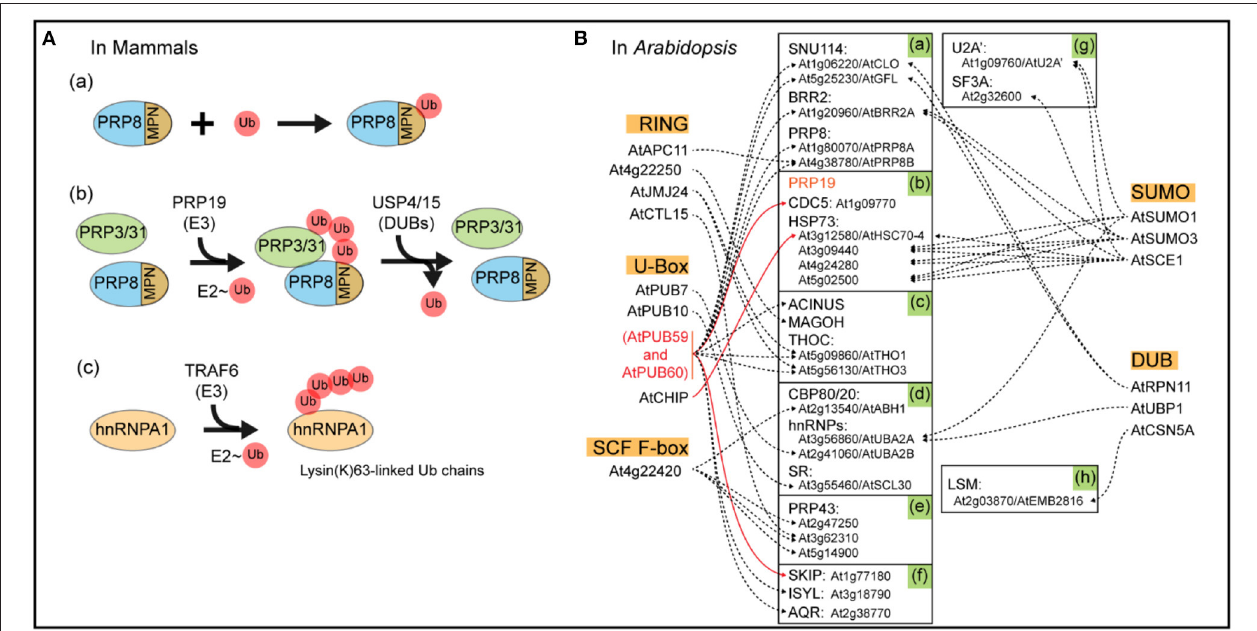
FIGURE 2 | Schematic diagram of ubiquitination in mammals and Arabidopsis. (A) Ubiquitination and deubiquitination of mammalian spliceosomal components. MPN, the MPN domain, a variant of the Jab1/MPN domain found in a class of deubiquitinating enzymes, located near the C terminus of PRP8p; Ub, Ubiquitin. (B) The ubiquitin-associated interacting proteins. Shown in the orange box are RING E3s, U-Box E3s, SCF F-box E3s, SUMOylation components, and DUBs of Arabidopsis spliceosomal components (https://www.kegg.jp/pathway/ath03040). Shown in the green highlighted boxes are components of U5 (a), PRP19 complex (b), EJC/TREX (c), common components (d), U2 related (e), Prp19 related (f), U2 (g), and U4/U6 (h). The solid line denotes established interactions; the broken line denotes putative interaction. These interactome networks were downloaded from the BioGRID 4.4 database